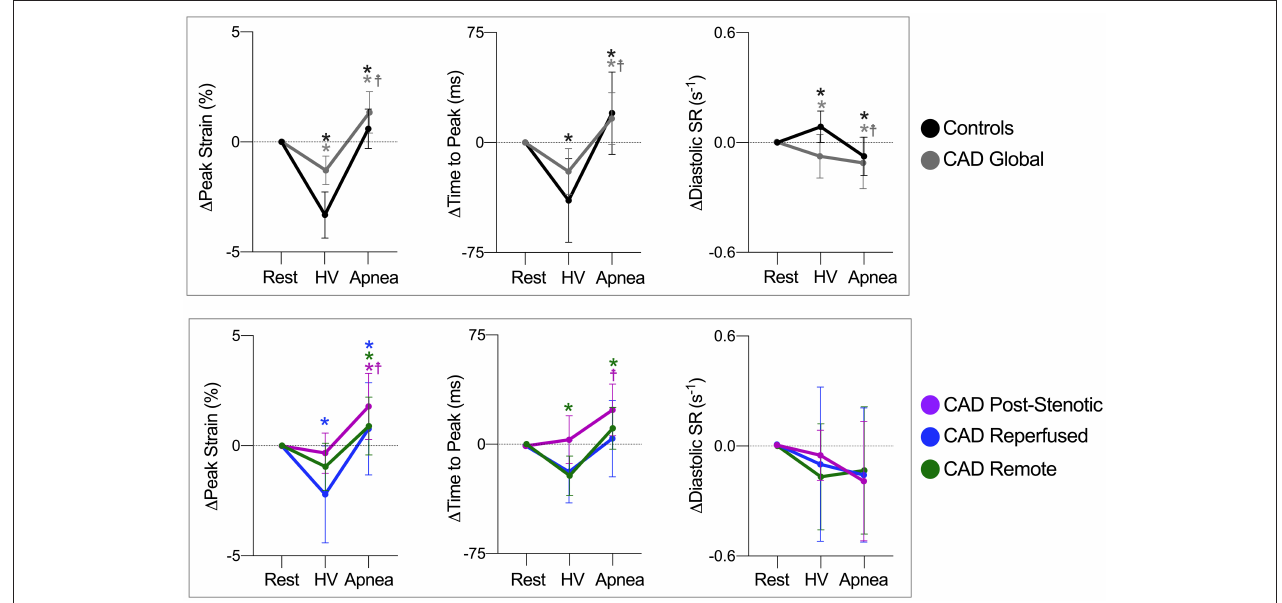
FIGURE 2 | Response of circumferential strain parameters to breathing maneuvers. Data are mean ( ± 95%CI) changes of global peak strain, time to peak strain and early diastolic strain rate (dSR) after hyperventilation (HV) and apnea. Global myocardial changes are shown on the top row for healthy controls (black) and coronary artery disease CAD patients (gray), and for angiography defined myocardial territories on the bottom. * p < 0.05 from the previous step, p < 0.05 at rest vs.